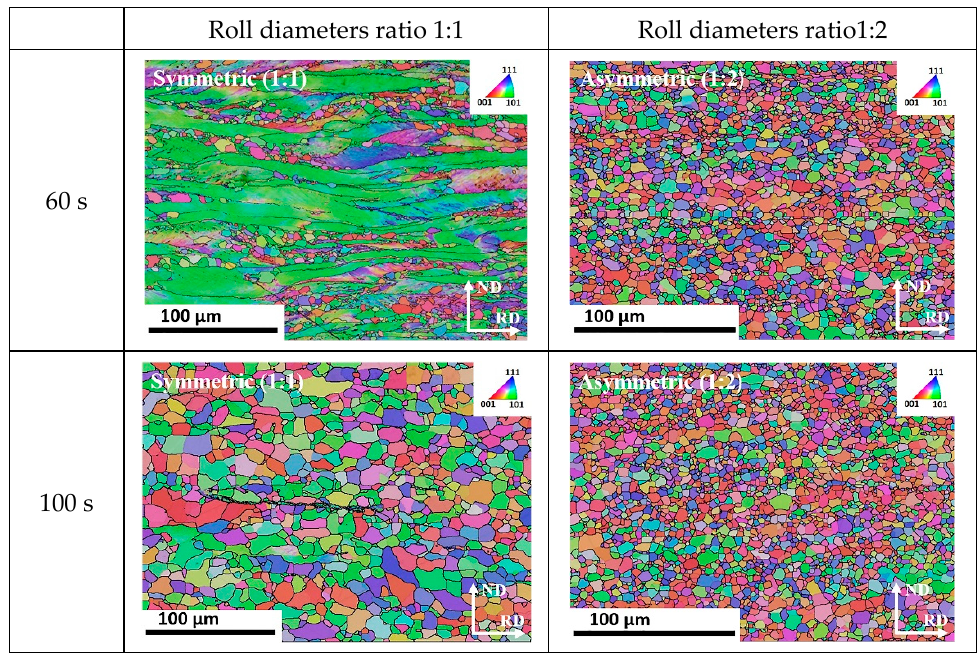
Figure 9. Recrystallization IPF maps (TD surface) in the mid thickness area of a sheet at 660 ± 10 °C for 75% thickness reduction per per pass.